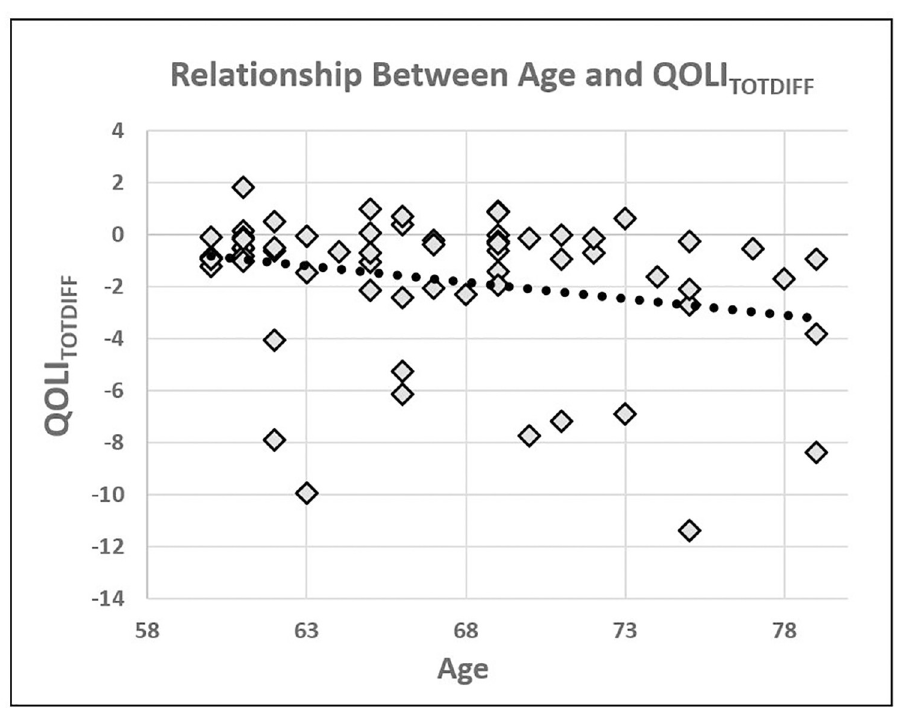
Fig 4. Plot showing the significant correlation between participant age and QOLI TOTDIFF . Older participants showed greater decreases in quality life as measured by the QOLI when comparing pre and post-isolation scores.